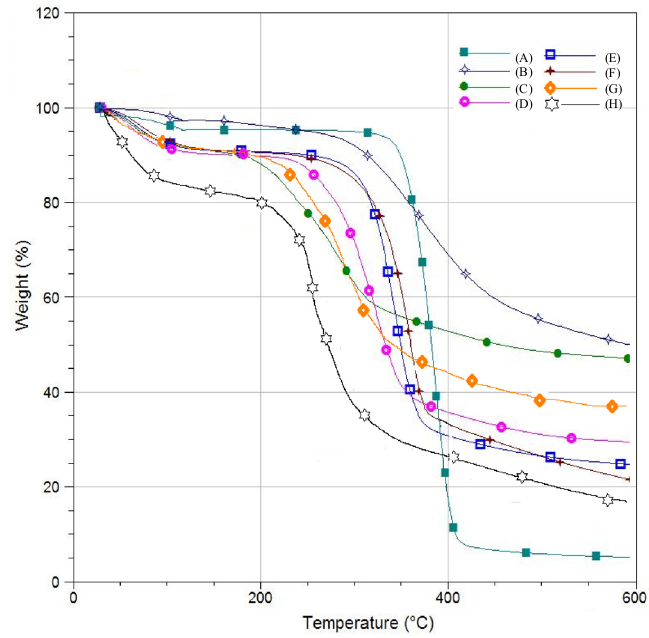
Figure 2. TGA of commercial cellulose ( A ); commercial lignin ( B ), cellulose A (preparation 1) ( C ); cellulose B (preparation 2) ( D ); cellulose C (preparation 3) ( E ); cellulose D (preparation 4) ( F ); cellulose E (preparation 5) ( G ); and CMSC ( H ).